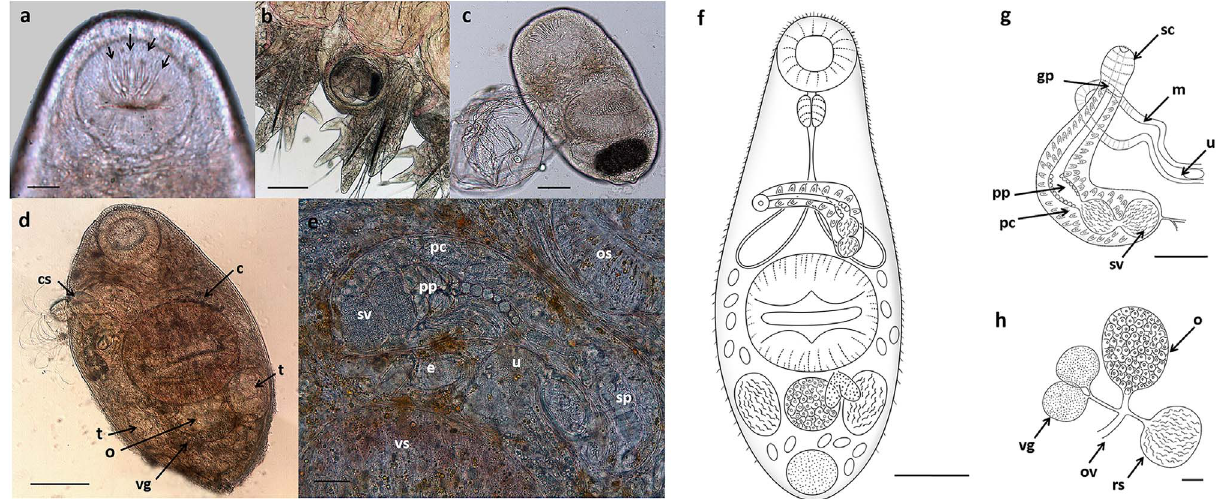
Figure 3. Microphotographs in vivo (a – e) and line drawings (f – h) of Diphterostomum fl avum n. sp . (Zoogonidae) parasitizing the fi sh Pinguipes brasilianus on the Patagonian coast, Argentina: (a) anterior end of cercaria from the gastropod Buccinanops deformis , ducts of penetration glands ending in the oral sucker (arrows), (b) metacercariae naturally encysted in a parapodium of the polychaete Kinbergonuphis dorsalis , (c) metacercariae excysted at laboratory condition, (d) adult from the fi sh Pinguipes brasilianus with everted cirrus, (e) cirrus sac, (f) adult ventral view, (g) cirrus sac, (h) female genitalia. Abbreviations : c, caeca; cs, cirrus sac; e, egg; gp, genital pore; m, metraterm; o, ovary; ov, oviduct; os, oral sucker; pc, prostatic cells; pp, pars prostatica; rs, seminal receptacle; sc, spinous cirrus; sv, seminal vesicle; t, testis; u, uterus; vg, vitelline glands; vs, vental sucker. Scales: 20 l m (a, e, h), 50 l m (c, g), 100 l m (b, d, f).